Question: Based on the figure, does the quantity rise or fall?
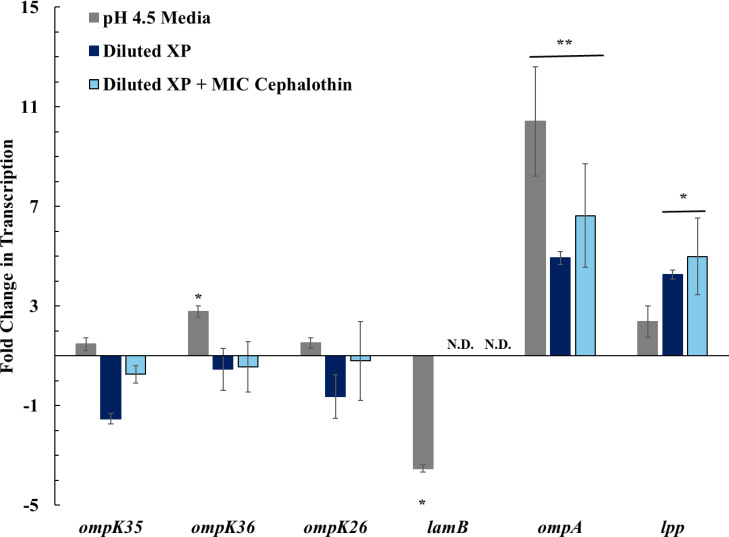
Answer: increasing